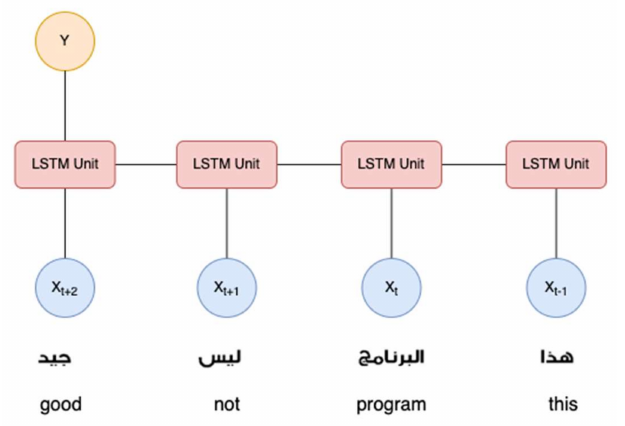
Figure 4. LSTM architecture.